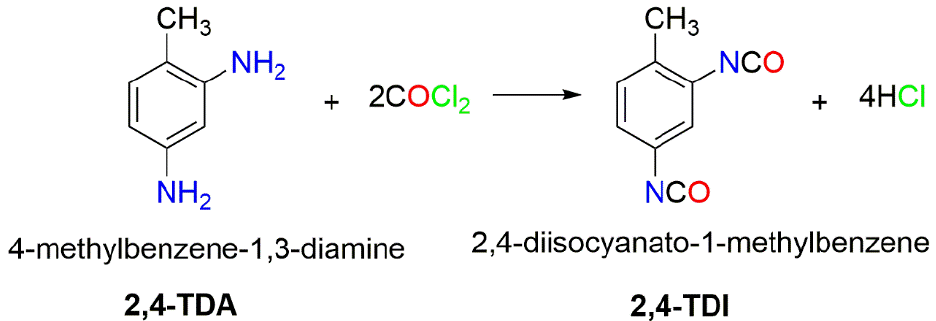
Figure 1. Reaction scheme for the phosgenation of TDA.